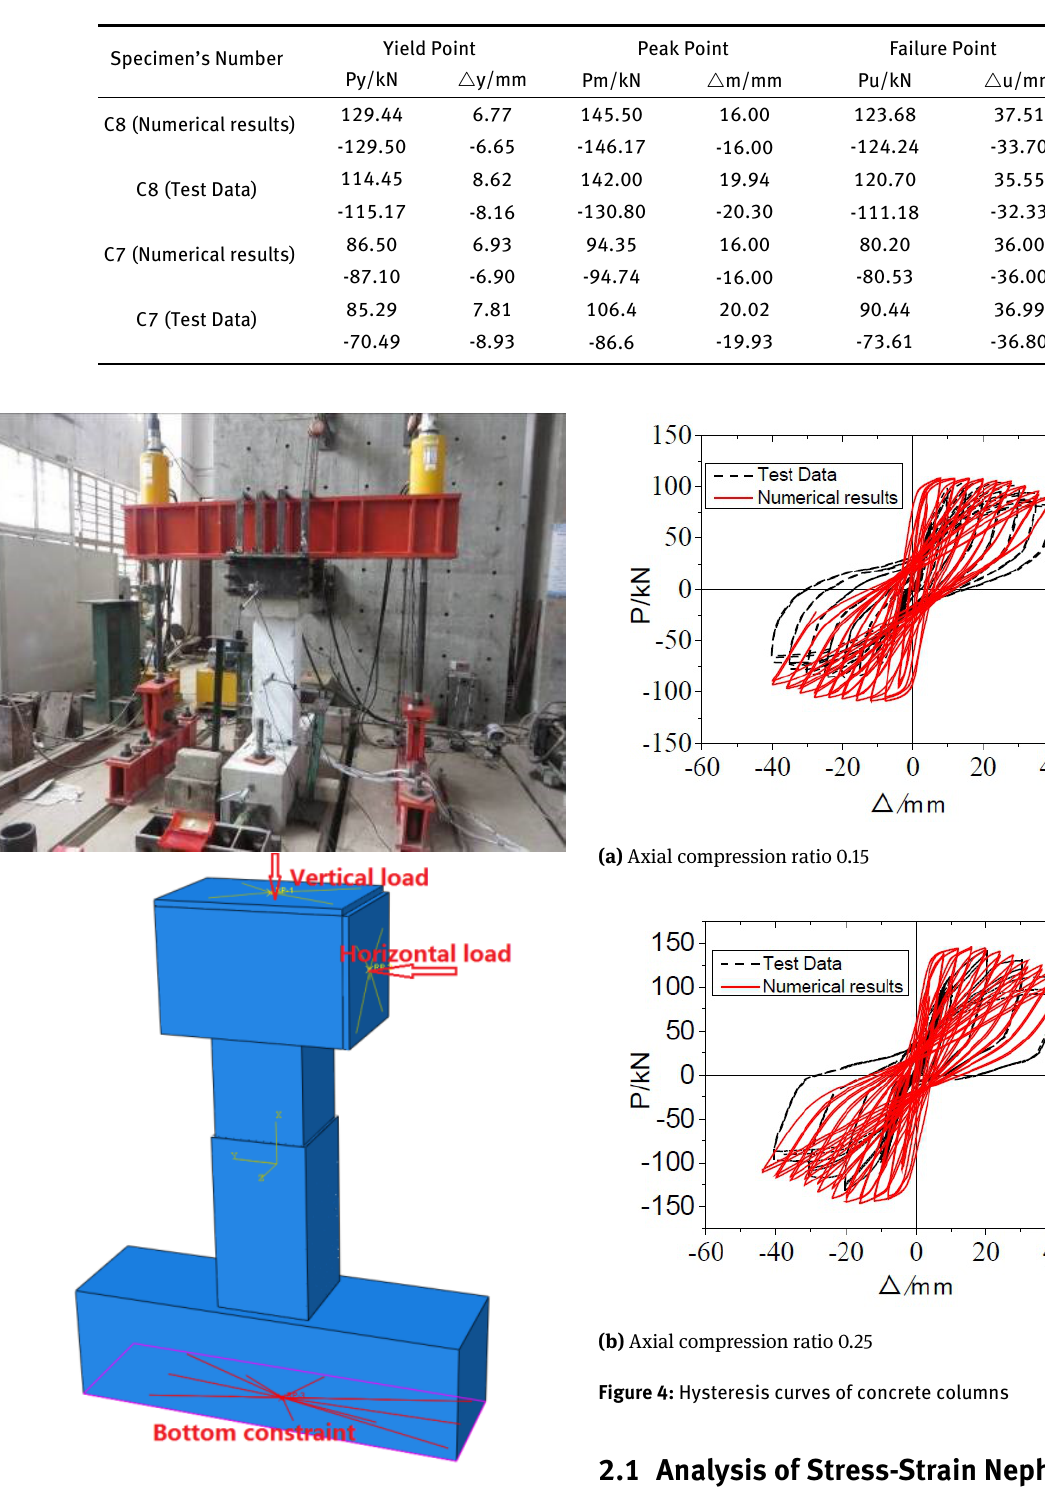
Figure 3: Loading apparatus